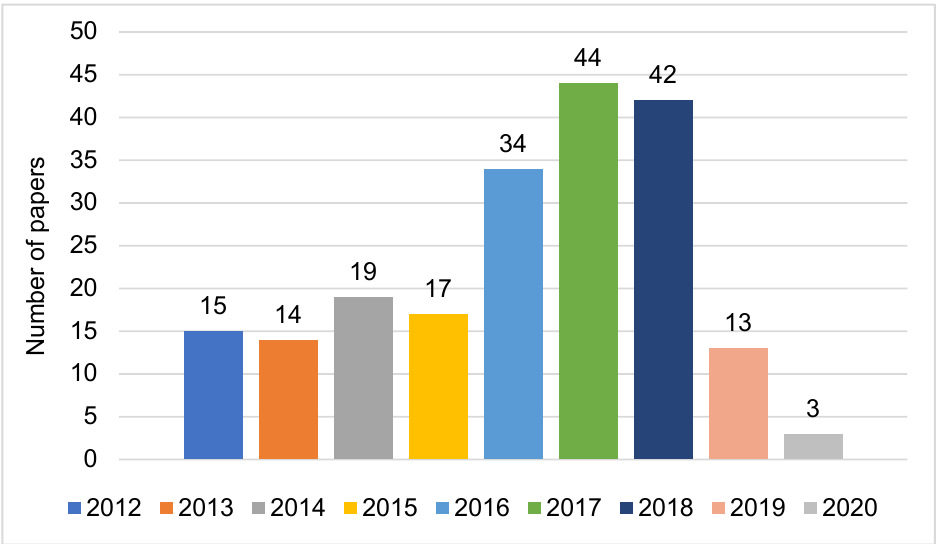
Figure 1. Number of research papers on mealworms published between 2012 and 2020 in Europe.